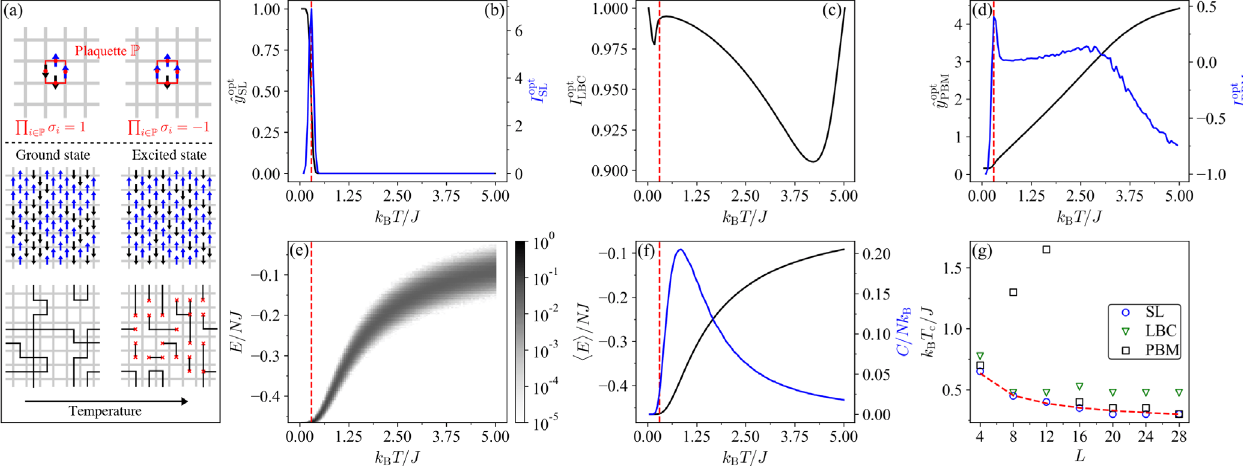
T=J , where p 1 ¼ 0 . 05 , FIG. 4. Results for the IGT ( L ¼ 28 ) with the dimensionless temperature as a tuning parameter p ¼ k B 5 , and Δ p ¼ 0 . 05 . In SL, the data obtained at p 1 and l p K . The crossover 1 and p K constitute our training set, i.e., r I ¼ K ¼ II ¼ T =J ∝ 1 = ln ð 2 L 2 Þ [87]. (a) Upper panels show examples of plaquettes P temperature is highlighted by a red dashed line and scales as k Q Q B c σ 1 ) and violated ( σ − 1 ). Middle panels show examples of spin where the topological constraint is met ( i ¼ i ¼ i ∈ P i ∈ P configurations within the topological ground-state phase (left) and phase with violated topological constraints at high temperature (right). Lower panels show the corresponding Wilson loops. (b) Mean optimal prediction ˆ y opt in SL (black line) and the corresponding SL indicator I opt (blue line). (c) Optimal indicator of LBC, I opt (black line). (d) Mean optimal prediction ˆ y opt in PBM (black line) and the PBM SL LBC (blue line). (e) Probability distributions governing the input data (here, the energy) as a function of the corresponding indicator I opt PBM tuning parameter, where the color scale depicts the probability. (f) Average energy per site (black line) and associated heat capacity (blue line) as a function of the temperature, where N ¼ 2 L 2 . Note that the heat capacity does not peak at the crossover temperature. (g) Estimated critical temperature based on I opt (SL), I opt (LBC), and I opt (PBM) as a function of the lattice size L PBM SL LBC